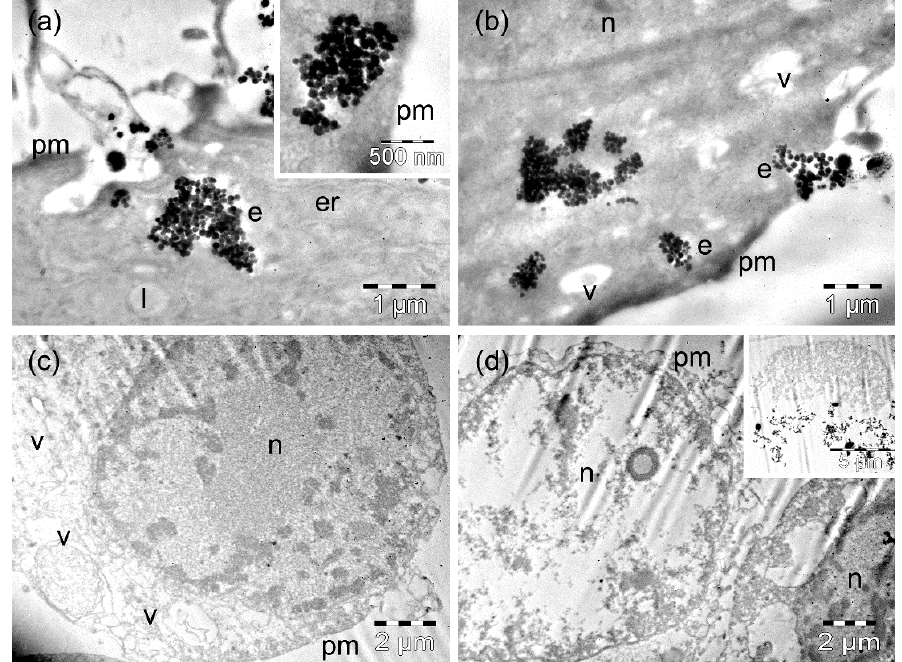
Figure 8. TEM images of MW35 cells containing ZnFe 3 O 4 MNPs after 4 h ( a , b ) and 24 h ( c,d ) of incubation time. The letters n, e, v, l, and pm denote the nucleus, the endosomes, the vacuoles, the lipid droplets, and the plasma membranes, respectively.